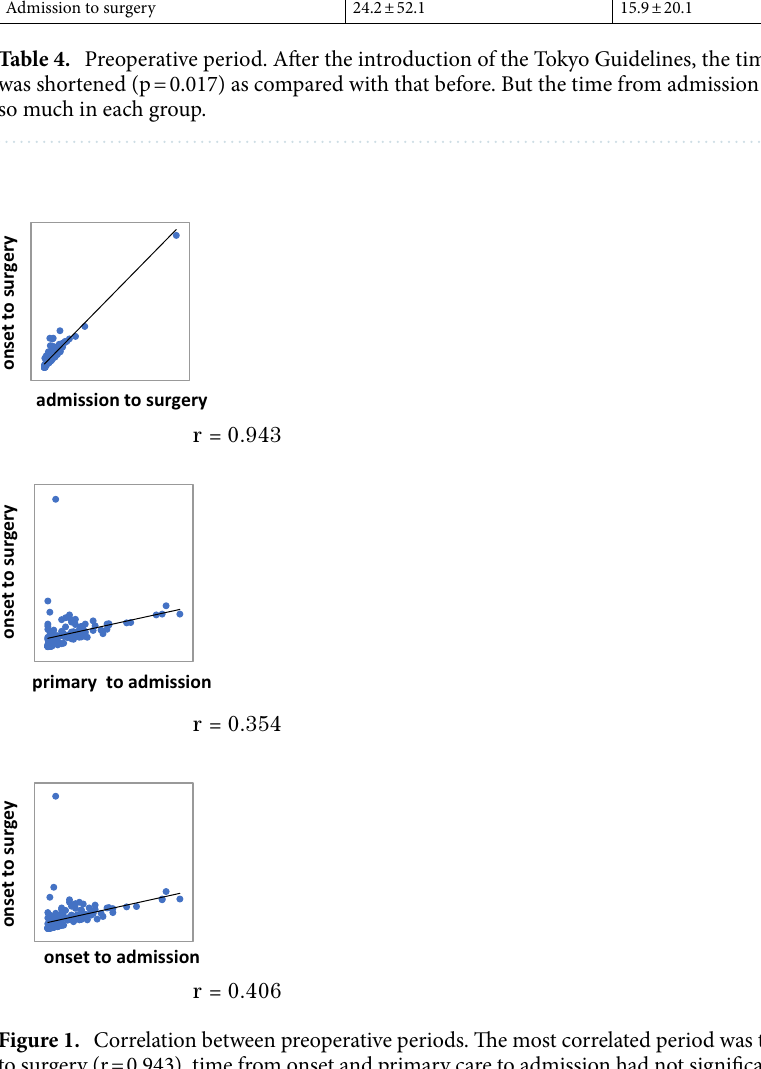
Post TG laparoscopic (81